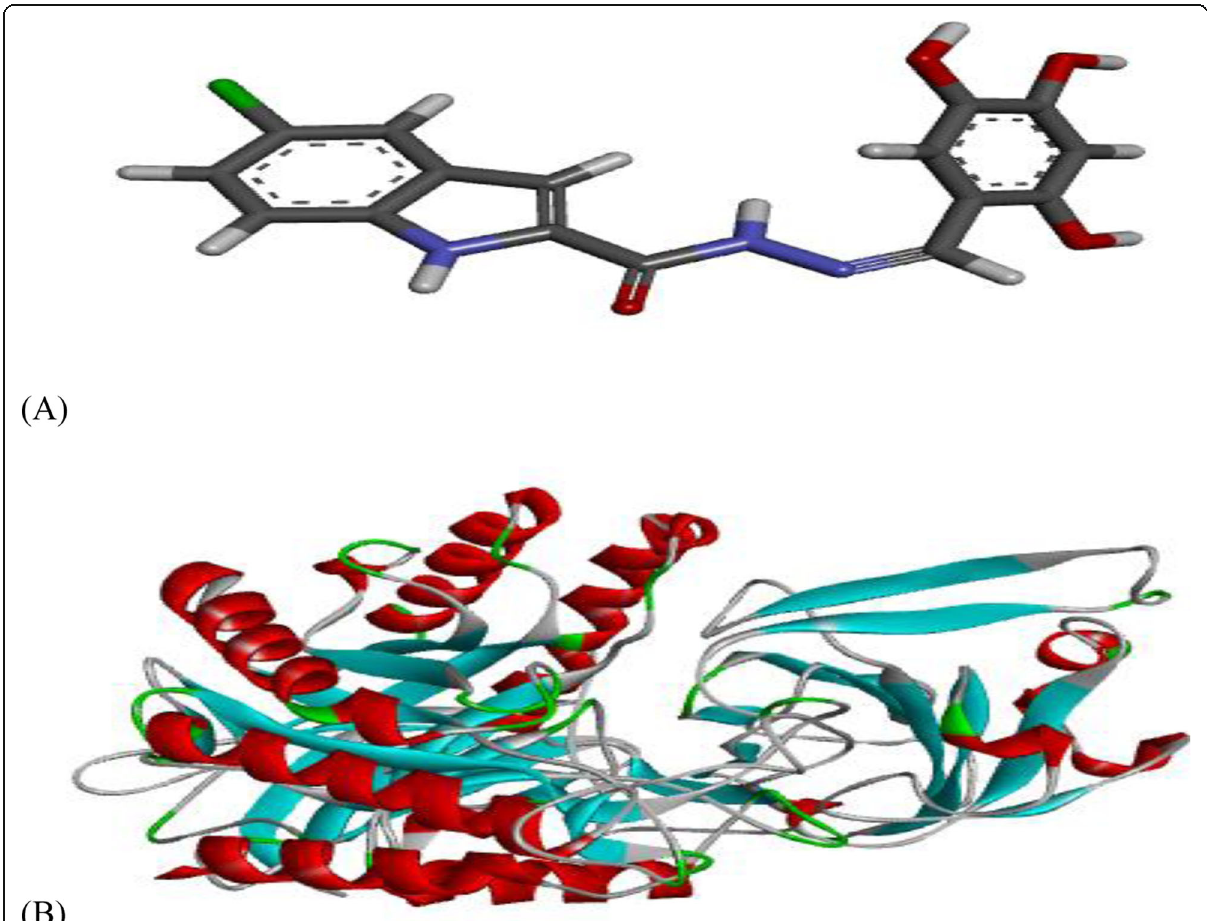
Fig. 2 The a 3D structure of the prepared ligand and b 3D structure of the prepared β